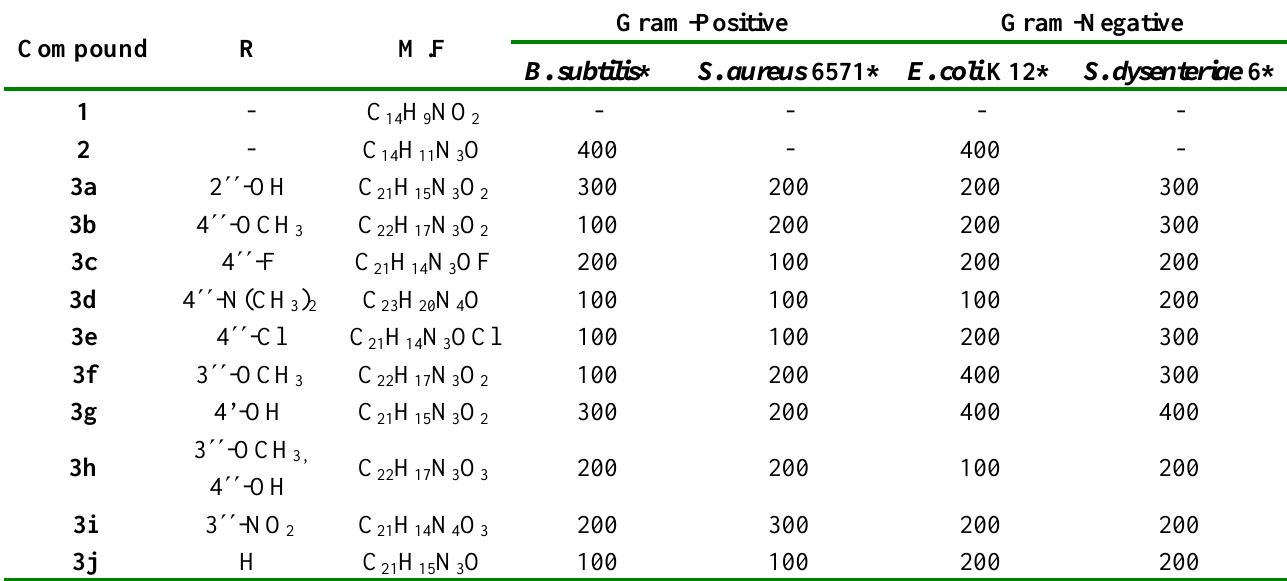
Table 1. Antibacterial activity (MIC) of synthesized compounds 3a-j